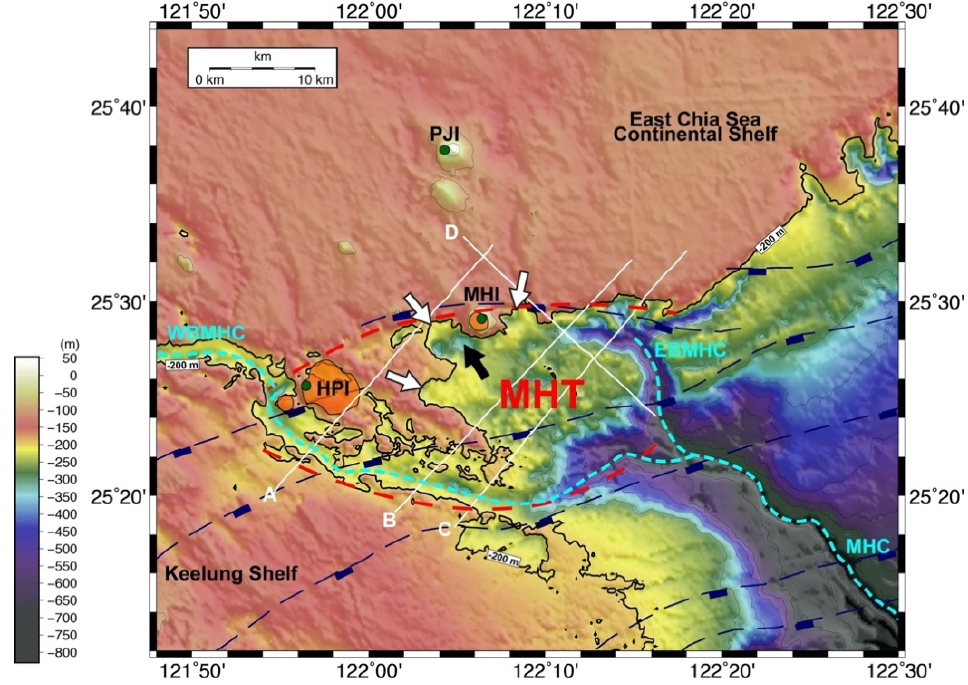
Figure 3. A 200 m grid bathymetric map showing the Mianhua Terrace (MHT) and distribution of the multichannel seismic (MCS) data. Light blue dashed lines indicate the thalweg of the Mianhua Canyon. Blue lines indicate extensional normal faults [12]. Orange areas indicate the Northern Taiwan Volcanic Zone (NTVZ) [14]. Green dots indicate the distribution of the Quaternary volcanic islets (HPI: Huaping Islet; MHI: Mianhua Islet; PJI: Pengjia Islet). White lines A, B, C, and D indicate the distribution of the MCS data. MHC: Mianhua Canyon; MHCWB: Mianhua Canyon West Branch; MHCEB: Mianhua Canyon East Branch.